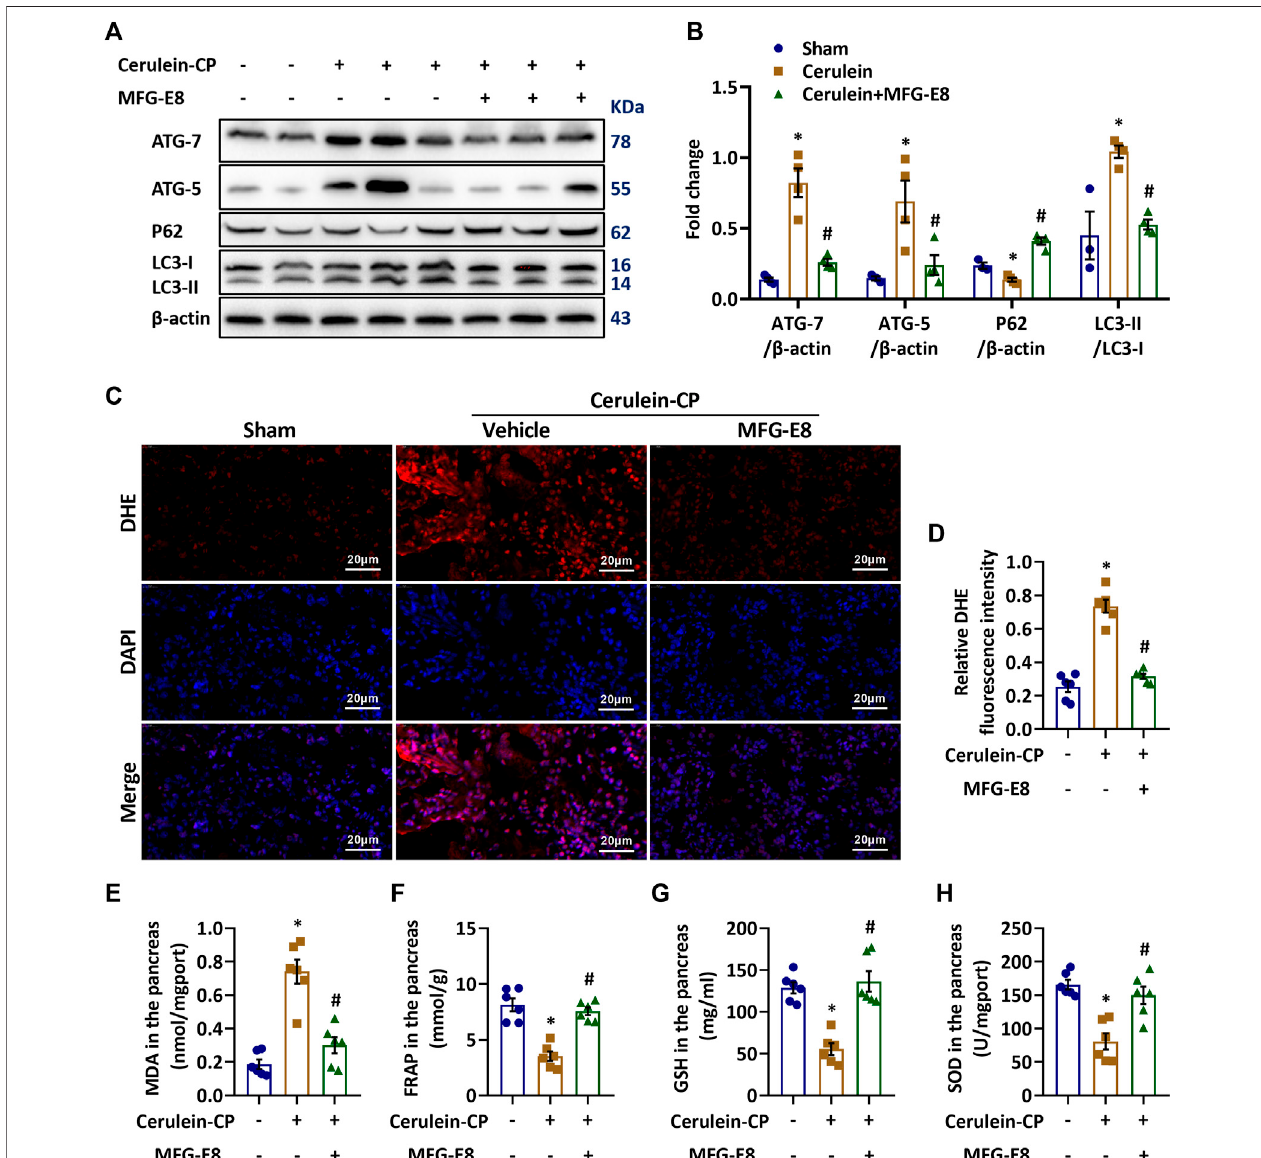
FIGURE 3 | Exogenous MFG-E8 Alleviates Autophagy and Oxidative Stress in Cerulein-CP. Cerulein-CP was induced by six IP injections of cerulein (50 μ g/kg/body weight) twice a week for 10 weeks. During the last 5 weeks, 1 h after cerulein injection, normal saline (vehicle) or 20 μ g/kg MFG-E8 was administered throughintraperitonealinjection.Thecontrolgroupreceivedthesamefrequencyandtimeofintraperitonealinjectionofnormalsaline(Sham).Theanimalsweresacri fi ced at2 daysafterthelastinjectionofceruleinornormalsaline.Bloodandtissuesampleswerecollected. (A,B) WesternblotanalysisoftheexpressionofATG7,ATG5, P62andLC3Binthepancreas(one-way ANOVA withtheTukey-Kramertest); (C,D) Representativeimages andquantitativeanalysisofimmuno fl uorescence stainingof DHE in the pancreas (one-way ANOVA with the Tukey-Kramer test); (E) FRAP level in the pancreas (one-way ANOVA with the Tukey-Kramer test); (F) GSH level in the pancreas (one-way ANOVA with the Tukey-Kramer test); (G) MDA level in the pancreas (one-way ANOVA with the Tukey-Kramer test); (H) SOD level in the pancreas (one-wayANOVAwiththeTukey-Kramertest). n (cid:1) 3 – 6,mean ± SEM; p p < 0.05versusShamgroup;# p < 0.05versusVehiclegroup.CP,chronicpancreatitis;MFG-E8, Milk Fat Globule-EGF Factor 8; MDA, malondialdehyde; SOD, superoxide dismutase; FRAP, Ferric ion reducing antioxidant power; DHE, Dihydroethidium; GSH, glutathione.